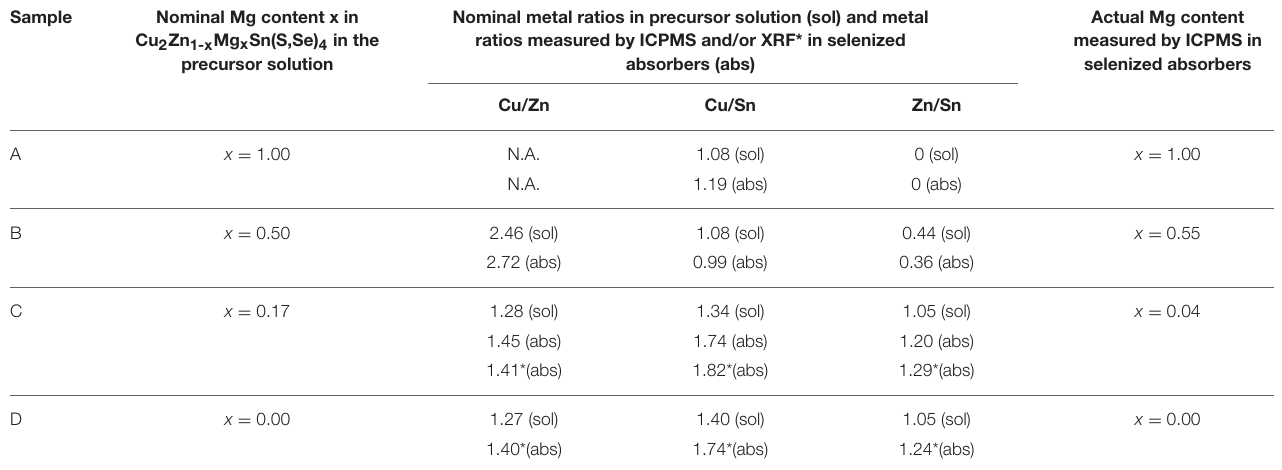
TABLE 1 | Mg content and nominal metal ratios in the precursor solution (sol) and selenized absorbers (abs) for all the samples.